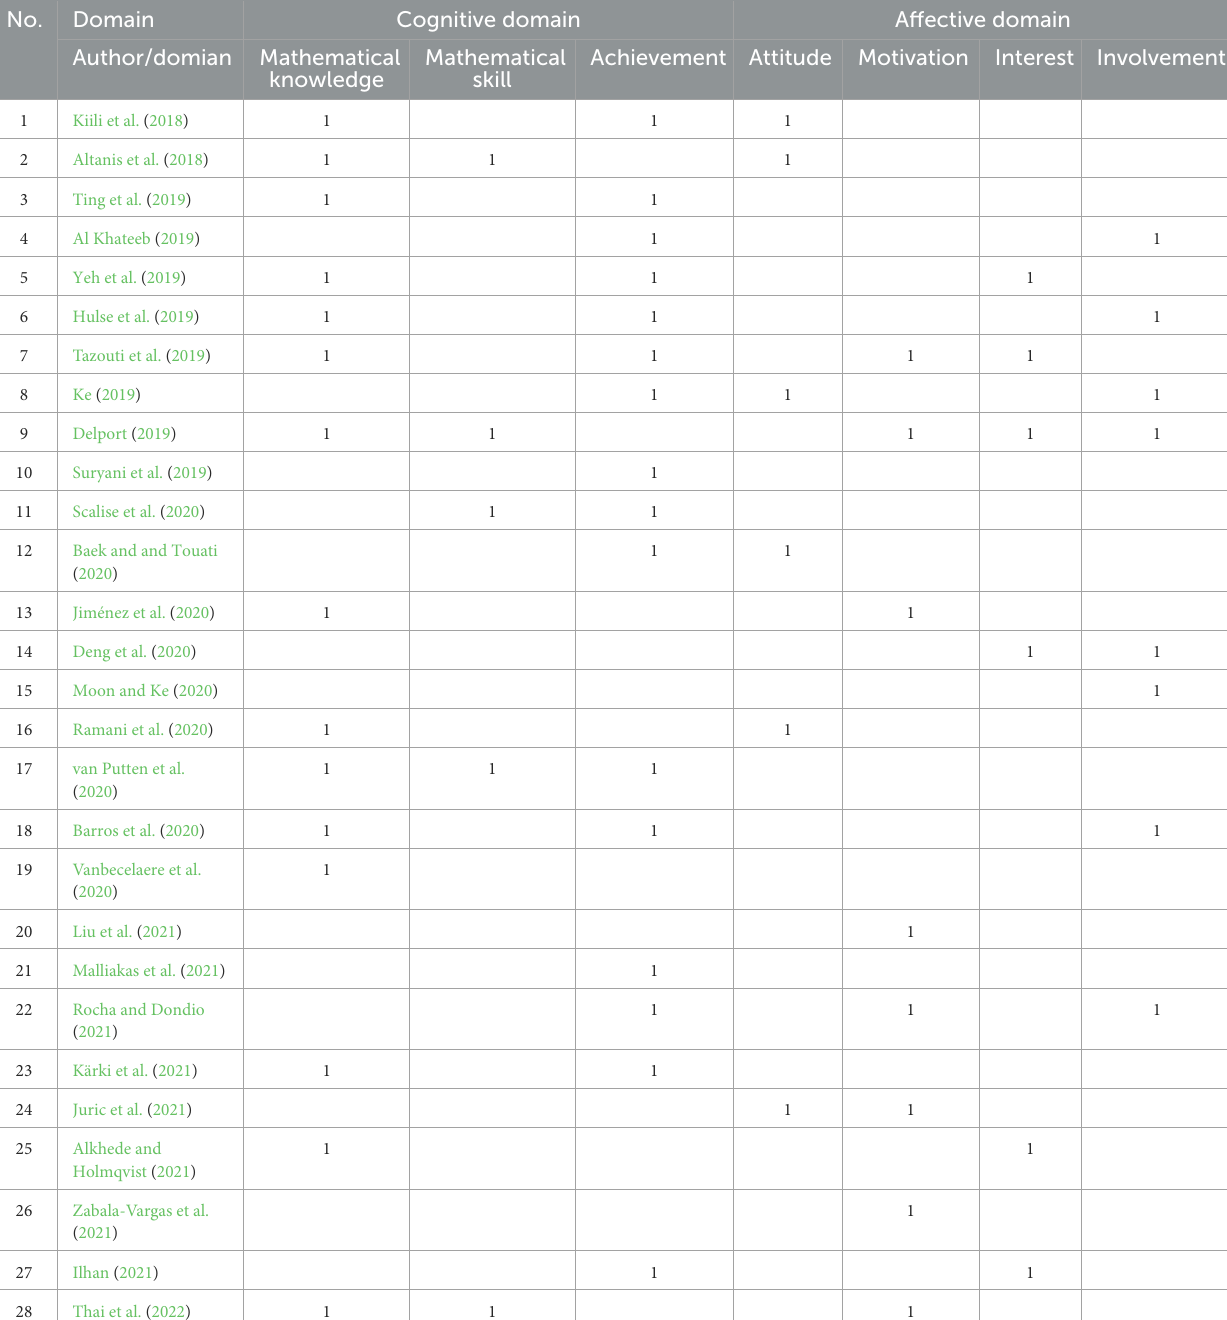
TABLE 5 Analysis of the previous studies on the cognitive and affective domains.